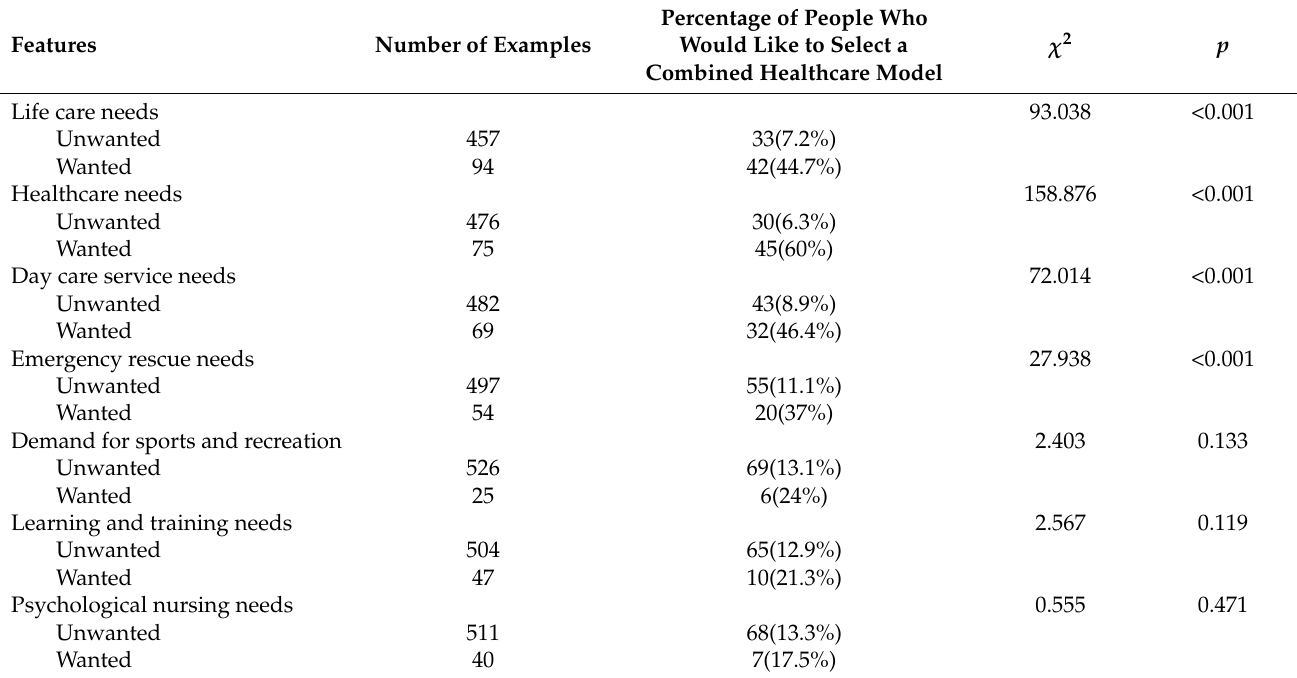
Table 3. Analysis of the willingness of the elderly to select the combined medical care and nursing care model with different needs.